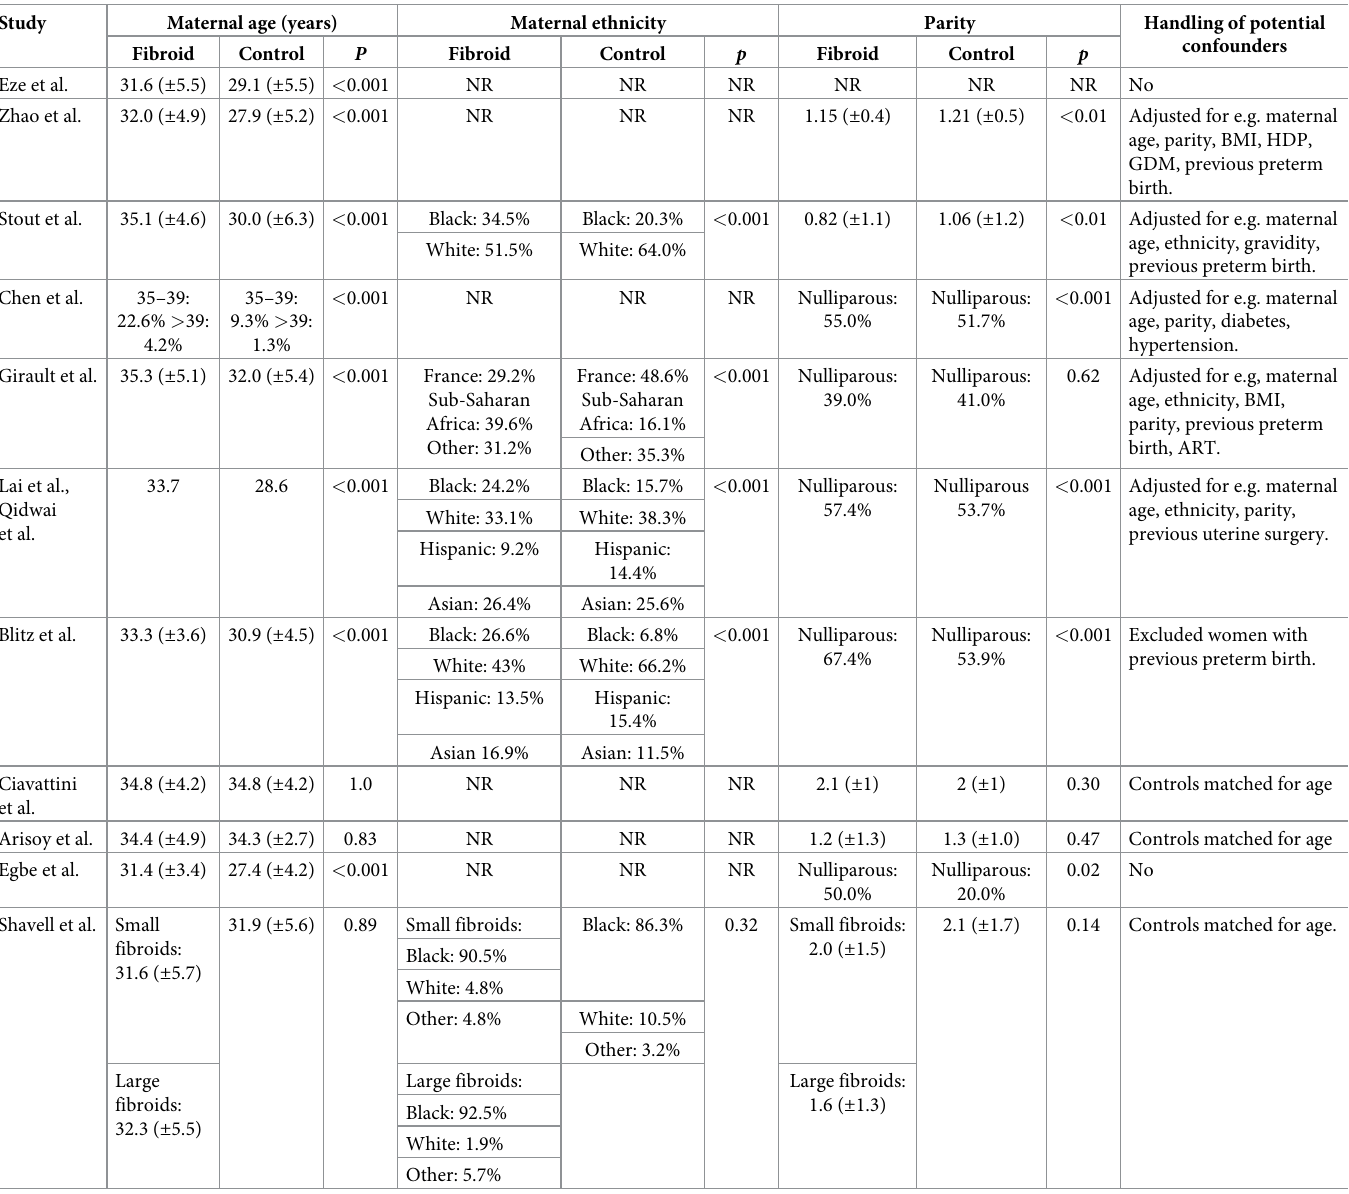
Table 3. Characteristics of the study population and handling of confounders. Study Maternal age (years) Maternal ethnicity